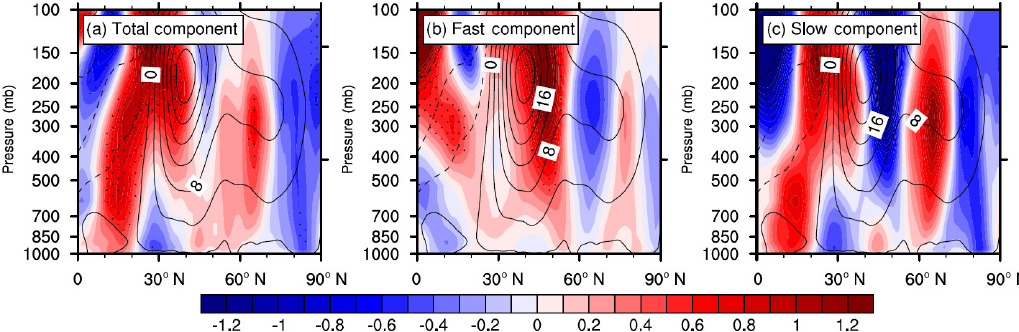
Figure 6. JJA mean total, fast, and slow responses of zonally averaged zonal wind between 100 and 140 ◦ E to SO 4 forcing (unit: ms − 1 ) . The dashed and solid lines represent the climatological JJA mean easterly and westerly winds in PI, respectively. The dots represent significance at ≥ 95% confidence level from the t